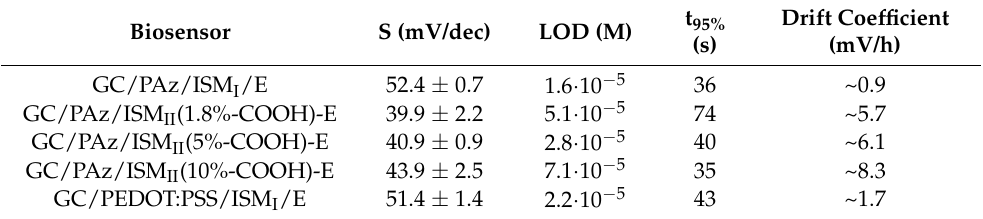
t 95% Drift Coefficient (s) (mV/h)